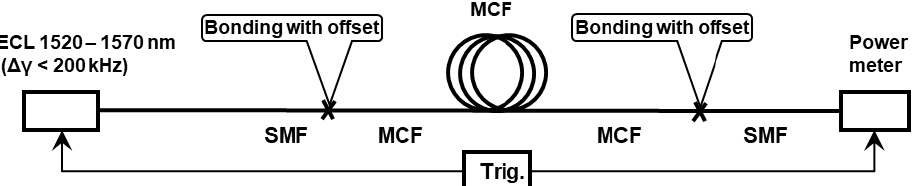
Figure 13. Measurement setup for crosstalk statistical characterization.